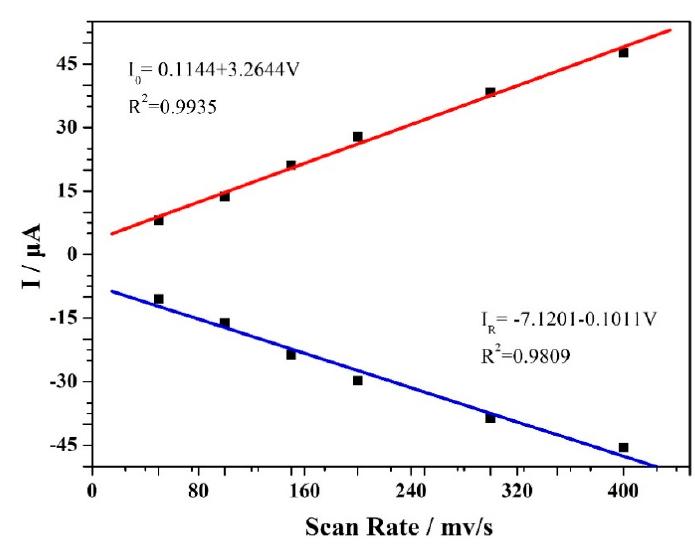
Figure 7. A plot of peak currents versus the scan rate based on CV curves at a scan rate of 20–300 mV·s − 1 .